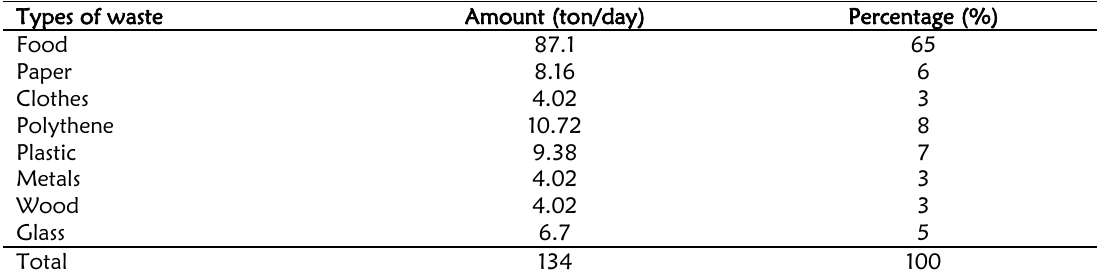
Table 8: Waste composition of Barisal city